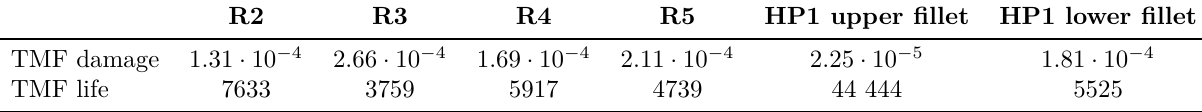
Table 1. TMF fatigue prediction results by the DOA in the selected domains of the steam